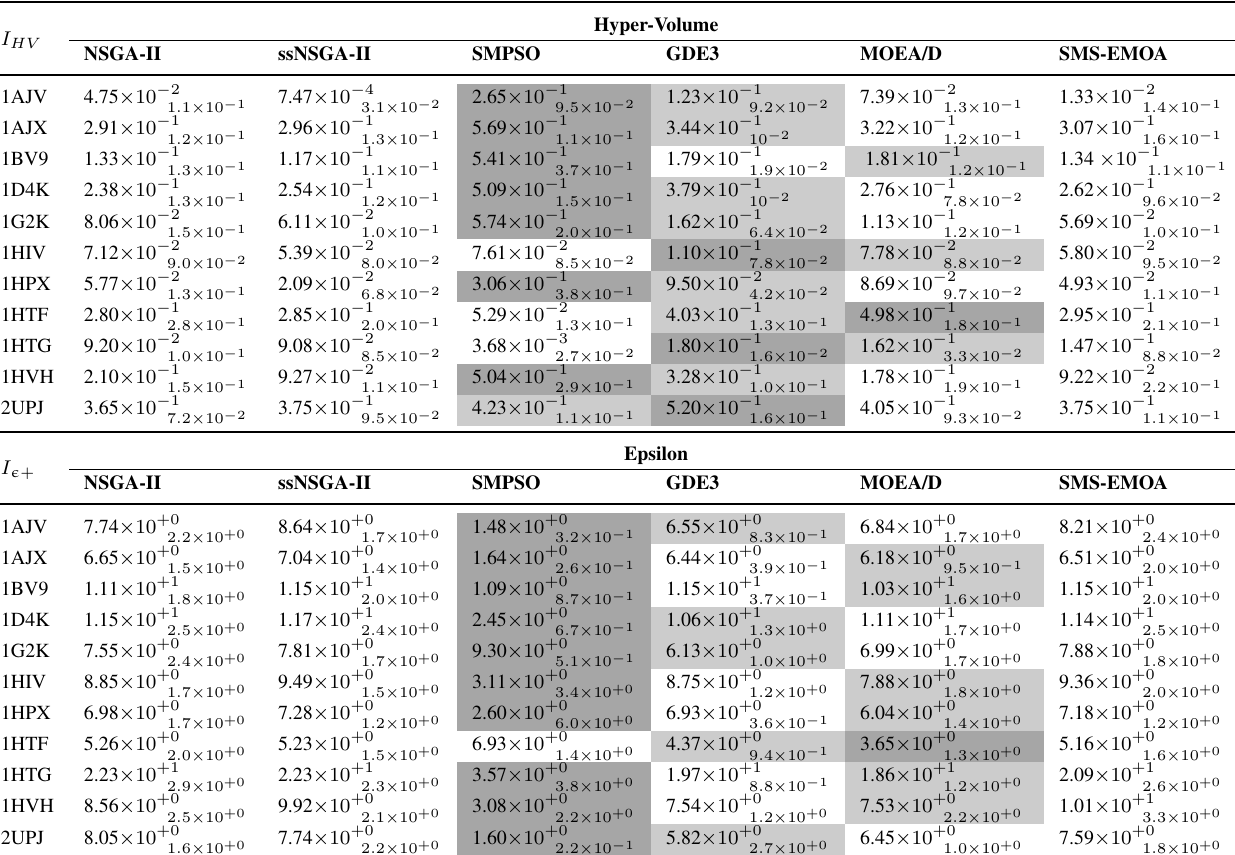
Table 1. Median and interquartile range of I algorithm and docking instance. Best and second best median results have grey and clearer grey backgrounds,